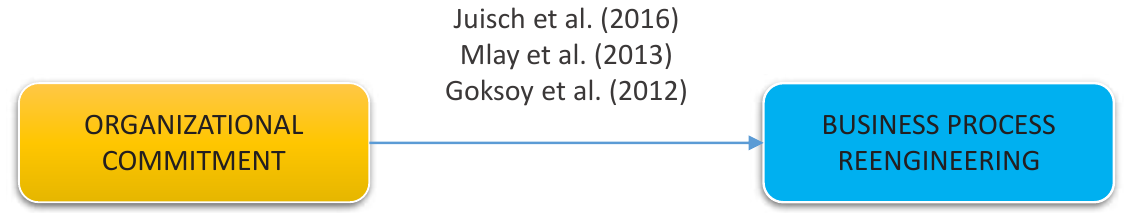
Figure 3. Organizational commitment relationship toward business process